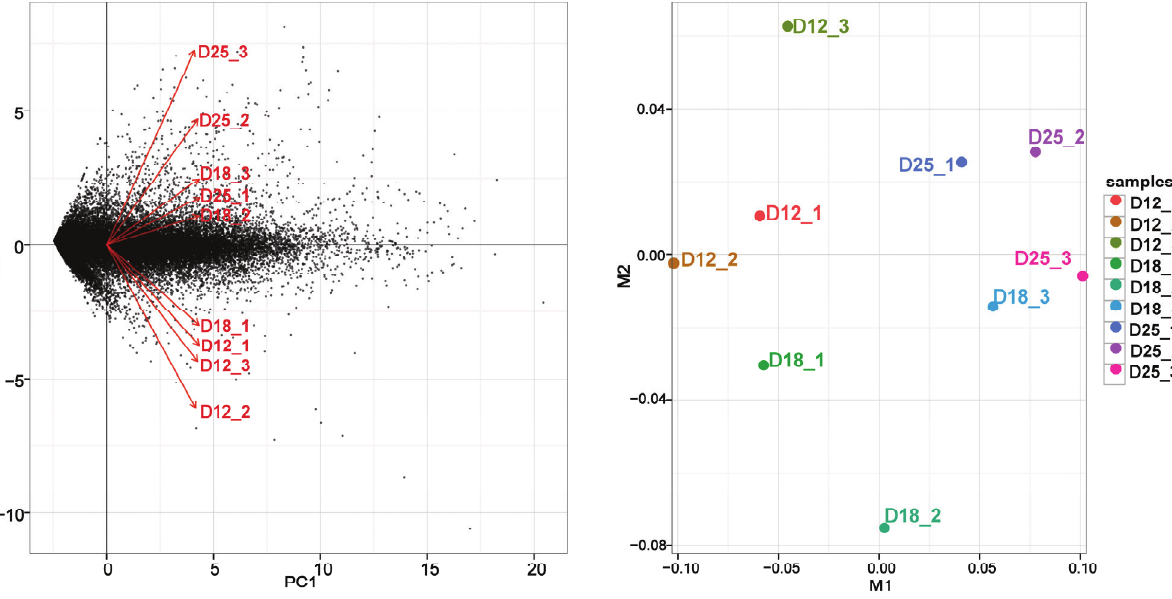
Figure 1. Principal component analysis (PCA) and multidimensional scaling (MDS) results of RNA-Seq data of endometrium on days 12, 18, and 25 of